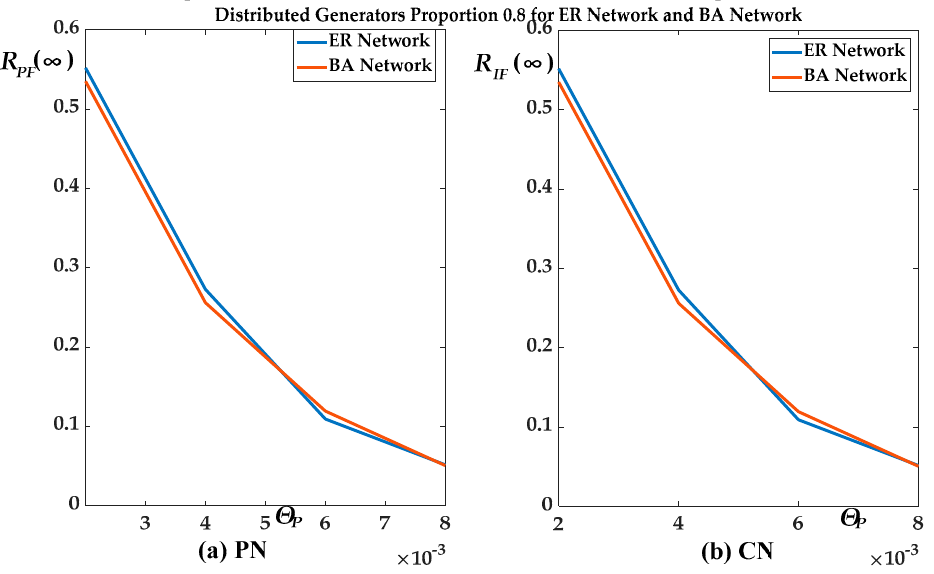
Figure 11. R PF ( ∞ )/ R IF ( ∞ ) of different network topology under different Θ P and proportion of distributed generators = 0.8.